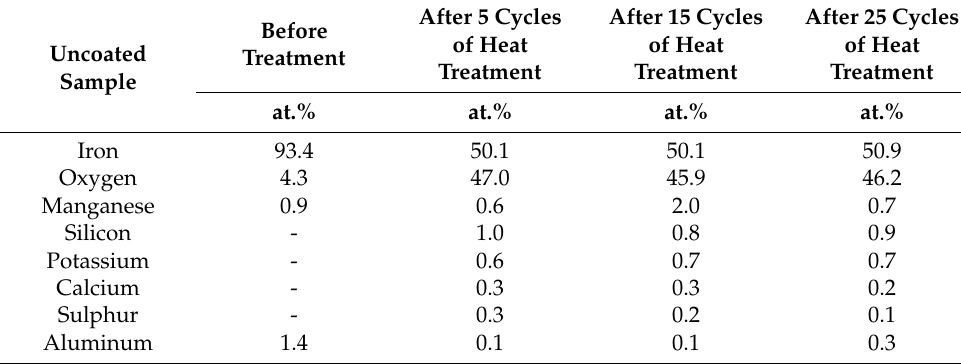
Table 3. Al 2 O 3 coating elemental composition.